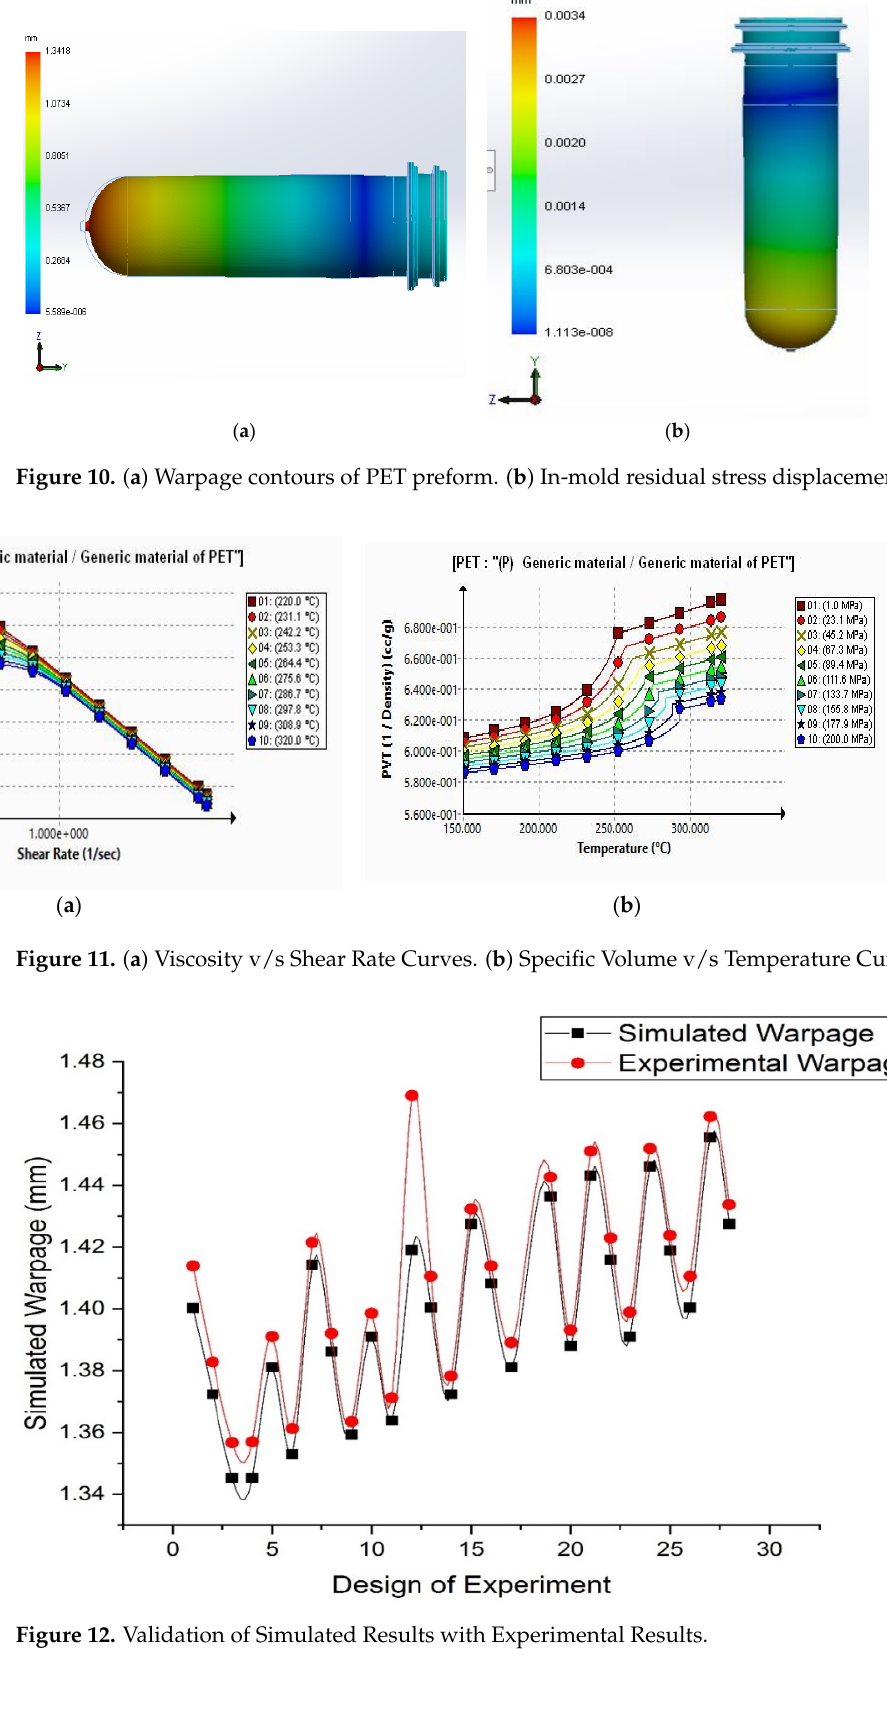
Figure 12. Validation of Simulated Results with Experimental Results .